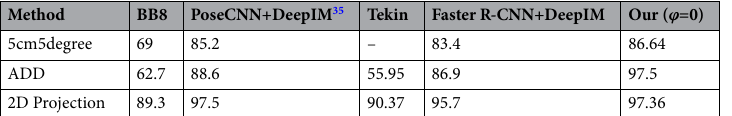
Table 5. Comparison with state-of-the-art methods on the LINEMOD dataset.